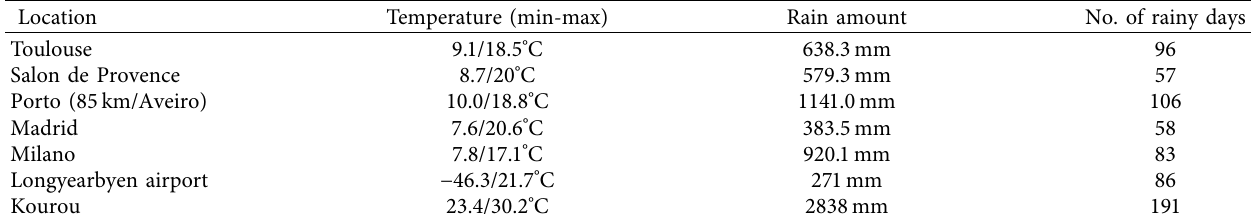
Table 3: Annual mean climatological normals (1981–2010) for the experiments considered in this analysis. Location